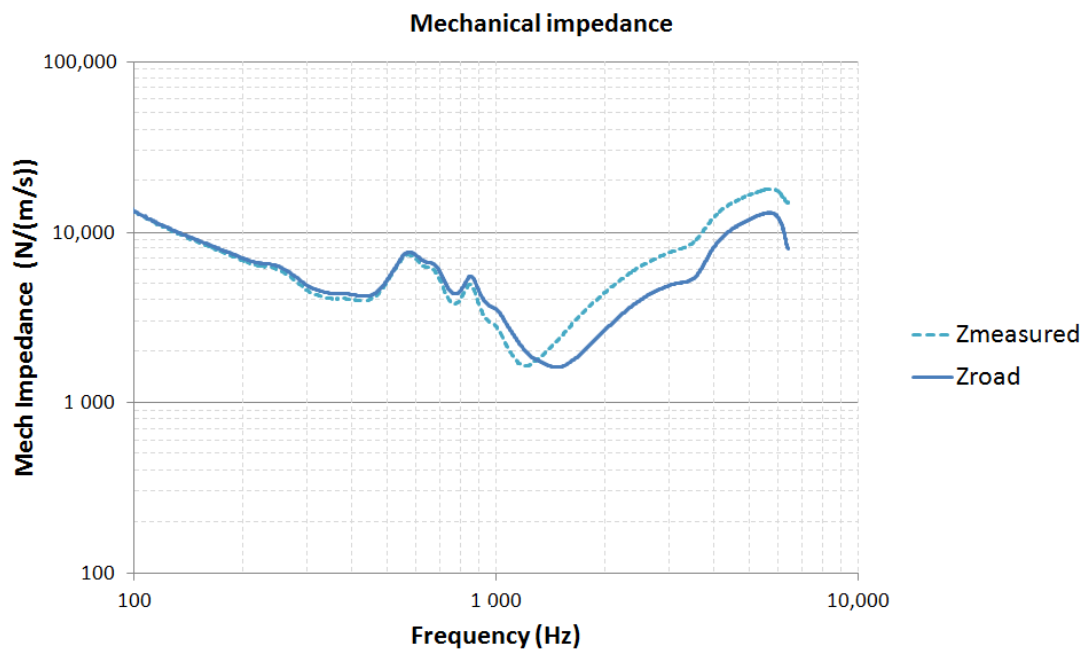
Figure 8. Impedance measurement and the mechanical impedance estimated for the road.